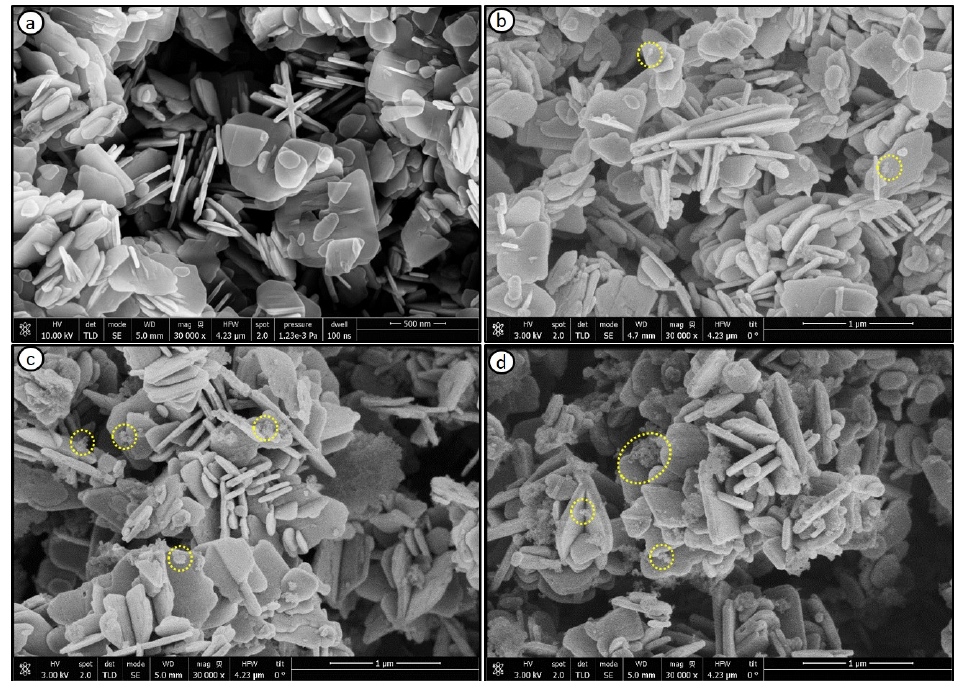
Figure 2. SEM images of ( a ) ZnO, ( b ) ZnO:Ce 1%, ( c ) ZnO:Ce 2% and ( d ) ZnO:Ce 3%. Catalysts 2019 , 9 , x FOR PEER REVIEW